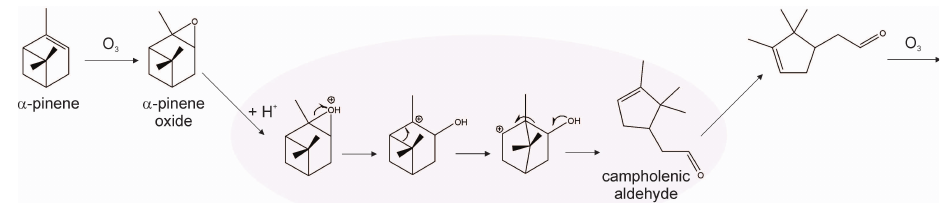
Fig. 2a. Formation of campholenic aldehyde during α -pinene ozonolysis. The shaded area represents a particle.